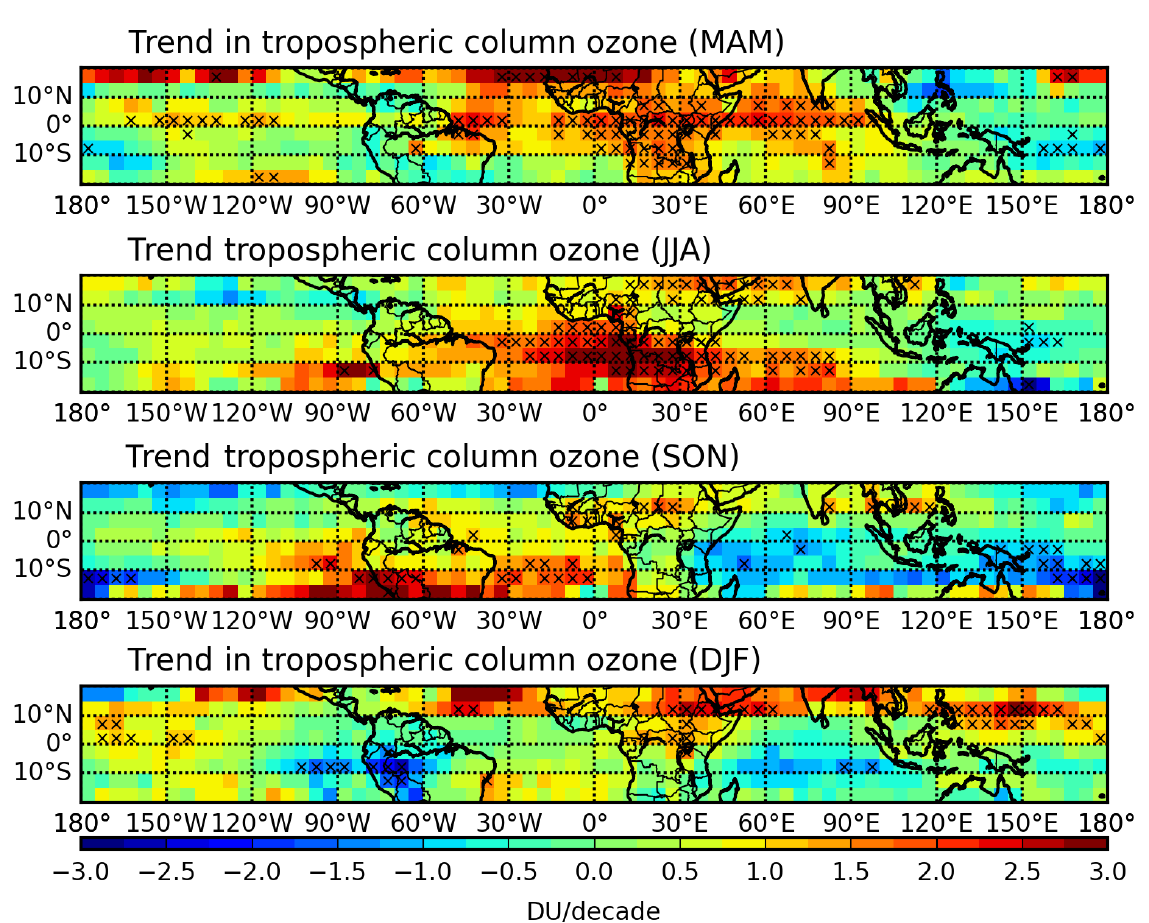
Figure 10. Same map as in Fig. 9 but for the different seasons. Note the different scale compared to Fig. 9. The main increase over southern central Africa and the Atlantic Ocean is found from June to August, which is the burning season in southern central Africa.